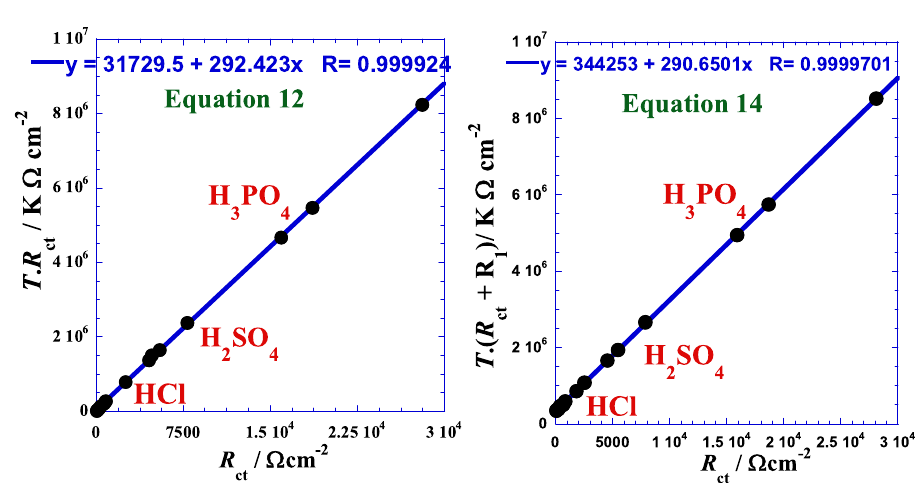
Figure 9. Linear correlation between the product temperature-charge transfer resistance T · R ct of Eq. (13) or T . ( R ct + R 1 ) of Eq. (15) and the charge transfer resistance R ct for overall the three acids.